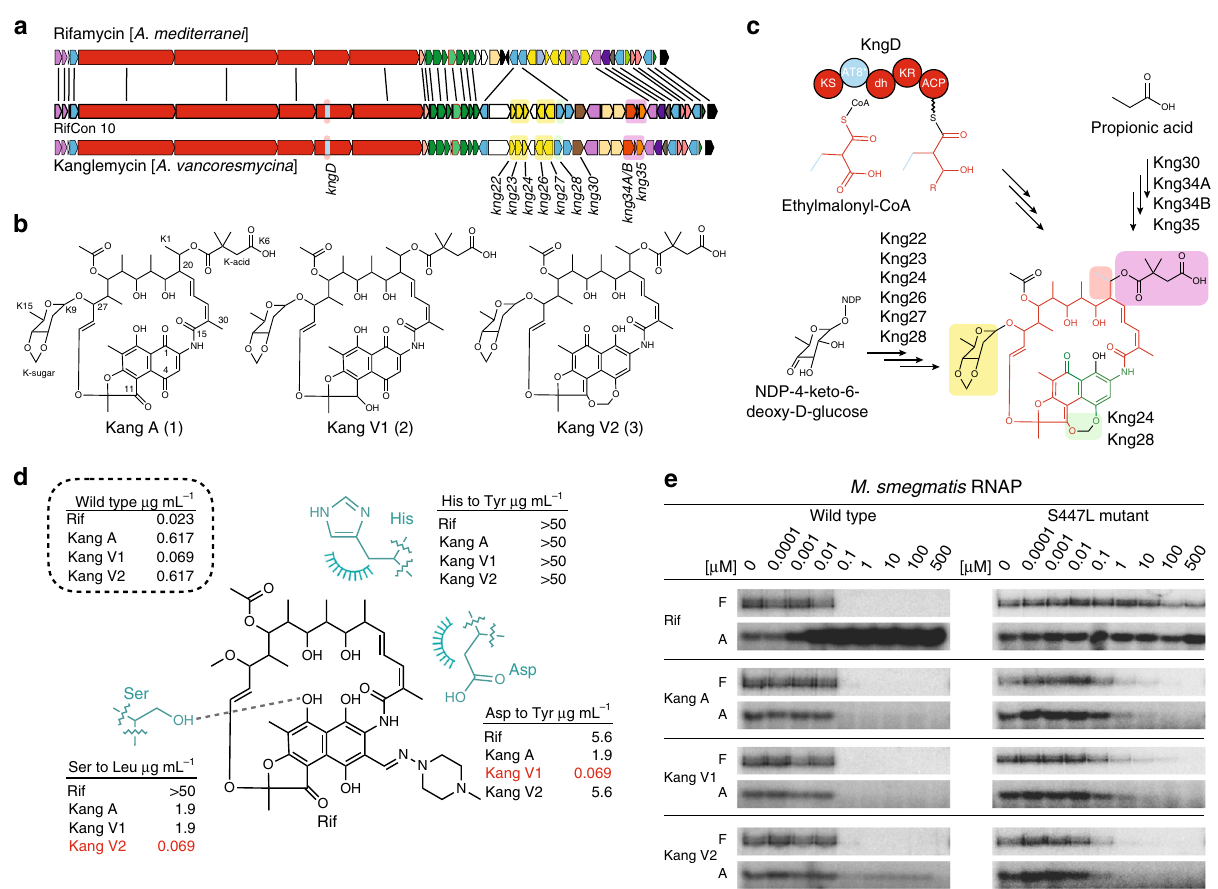
Fig. 3 Analysis of the kng gene cluster and the activity of Kangs A, V1, and V2. a Comparison of the rifamycin ( rif ) and Kang ( kng ) gene clusters. Lines connecting the two clusters indicate genes that are predicted to be functionally equivalent. For simplicity, only genes lacking a counterpart in the rif cluster are labeled in the kng cluster. Colored boxes surrounding these genes correspond to the substructures they are predicted to encode (shown in panel C). b Structures of Kangs A, V1 and V2. c Summary of the proposed biosynthesis of Kang V2. The structure of Kang V2 is colored as follows: red, PK core; blue, Emal modi fi cation; green, AHBA-derived substructure; black, tailoring modi fi cations. Colored bubbles highlighting the key structural features of Kang V2 correspond with the genes in (A) that are predicted to encode for these features. The PKS module 8 dehydratase (dh) domain, which is predicted to be inactive, is shown in lower case letters to differentiate it from the remaining, active domains. d In vivo activity pro fi les of the Kangs against Rif R Sau . The structure of Rif is shown along with the three most commonly mutated RNAP residues in Rif R Mtb clinical isolates 3,29 . The dashed line and arcs indicate an H-bond and nonpolar contacts, respectively. e . In vitro transcription assay with radiolabeled nucleotides showing the activity of Rif and the Kangs at the concentrations indicated against Msm wild-type and Rif R β S447L RNAP. F, full-length transcript; A, abortive